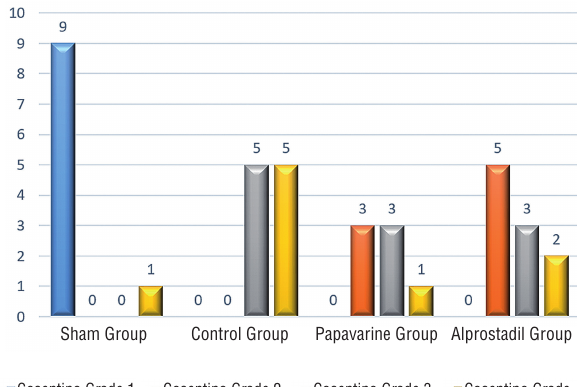
figure 3 - Distribution of the groups according to cosentino